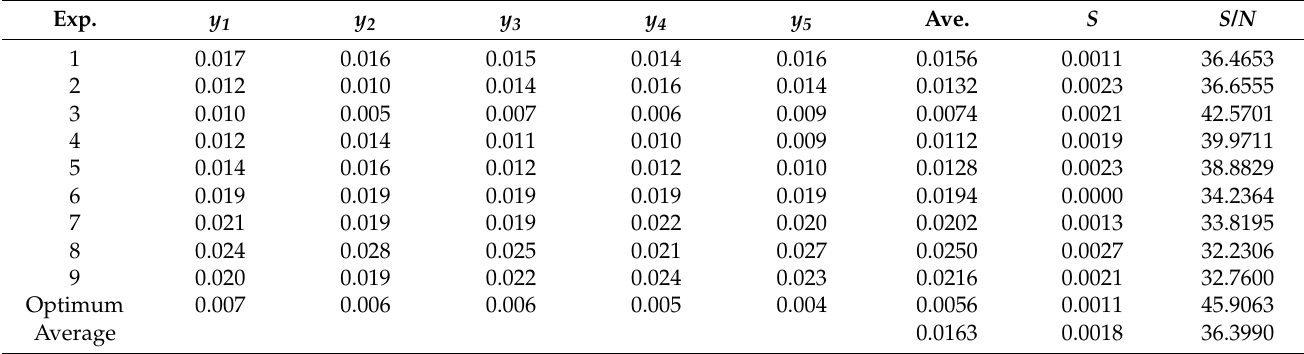
Table 4. S/N ratio of warpage of gear part for the